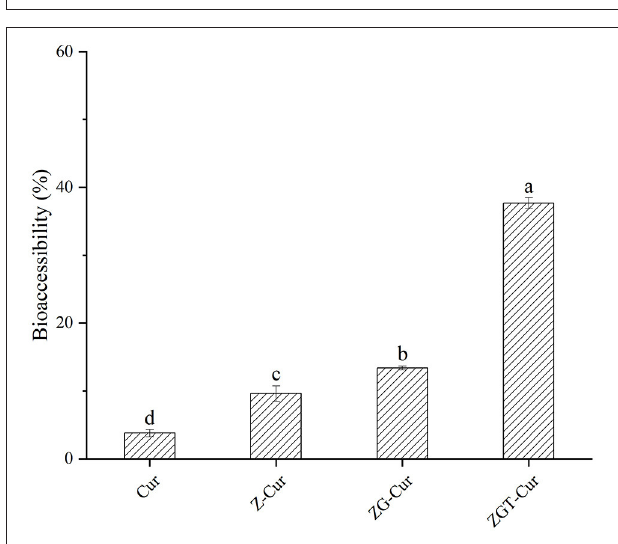
FIGURE 10 | Bioaccessibility of curcumin (Cur) in composite